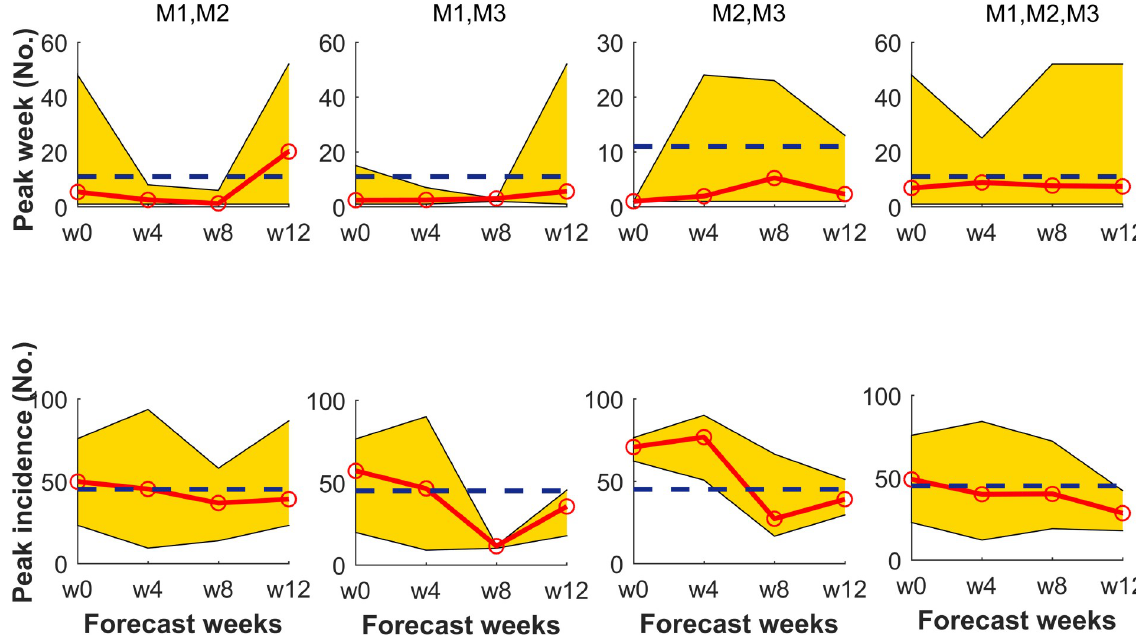
Fig 5. Best fit obtained from a combination of 2-strain models. Each model was aimed at predicting MERS-CoV epidemiological targets (top-peak week (No.), bottom-peak incidence (No.)) in Riyadh. Panels showing peak week and peak incidences are displayed up to the time of occurrence (11th week). Representations of the 2-strain models M1, M2, and M3 are the same as in Fig 2A. Dashed lines are observed